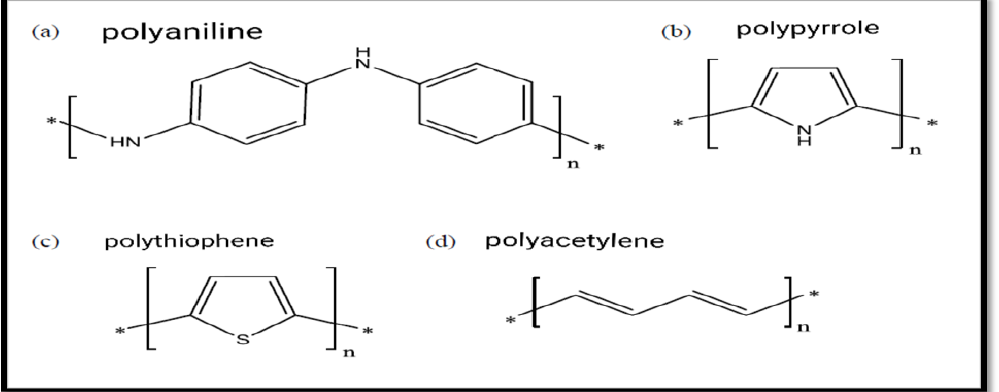
Fig.1: The structures of conducting polymers shown uncharged (a) polyaniline, (b) polypyrrole, (c) polythiophene and (d) polyacetylene [5].